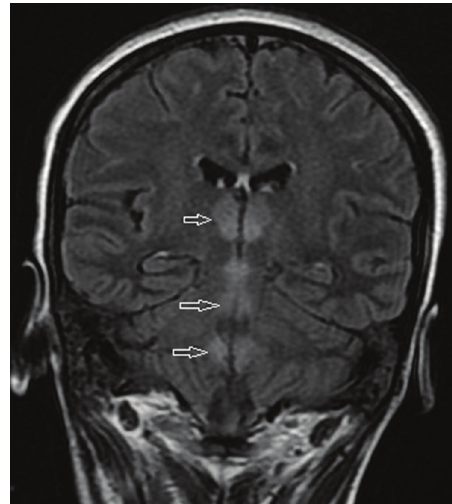
Figure1:Magneticresonanceimagingofbrainshowedsymmetrical hypersignal intensity at bilateral posterior thalamus and periaque- ductal area on fluid-attenuated inversion recovery